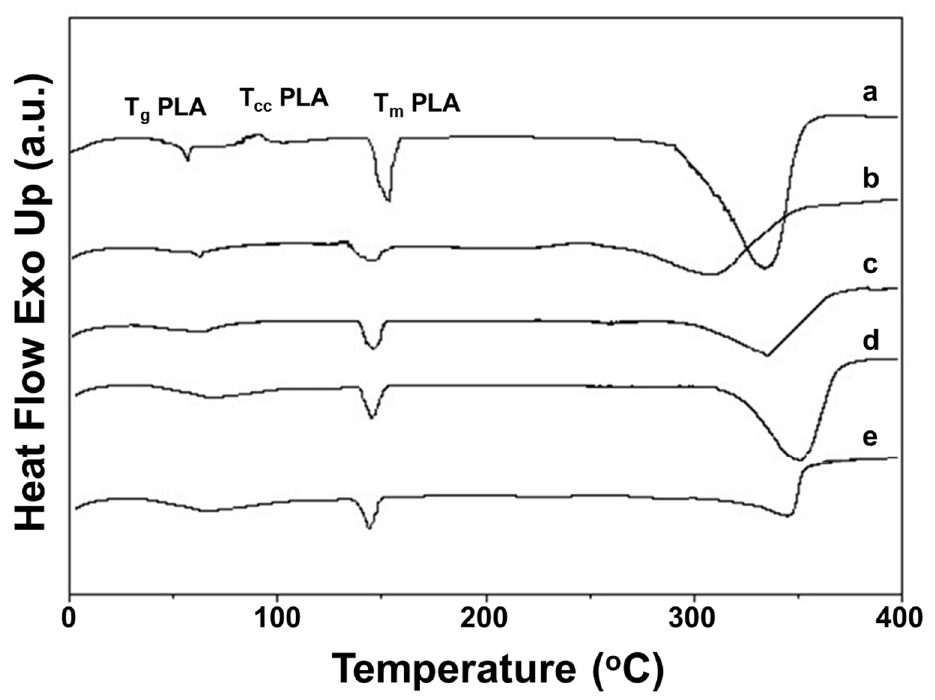
Figure 4. DSC thermograms of mats from (a) PLA, (b) Ch/PLA, (c) Ch-8Q/PLA, (d) Cu 2+ complex of Ch-8Q/PLA and (e) Fe 3+ complex of Ch-8Q/PLA.